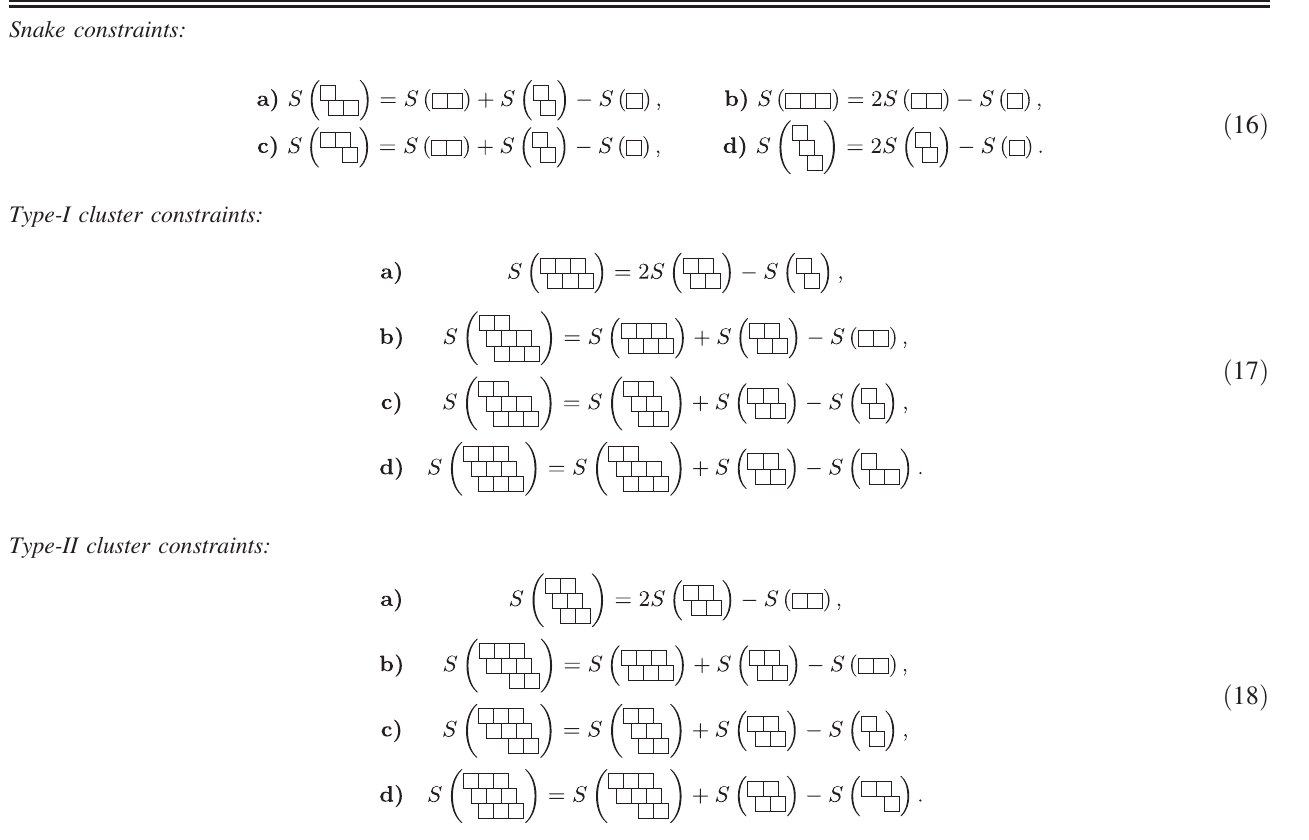
TABLE I. Descendant constraints. These identities follow from C L and C M;P . Snake constraints: